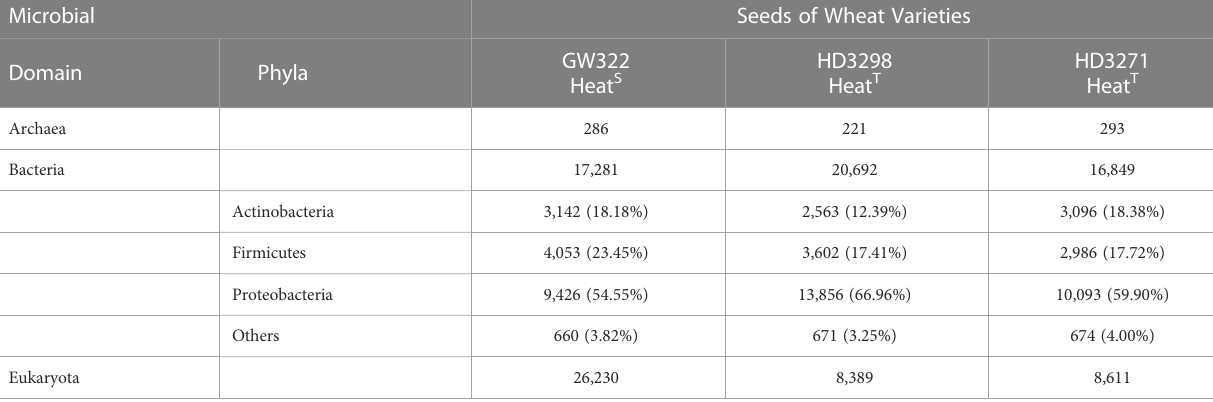
TABLE 3 Taxonomy abundance of microbial OTUs in the seed metagenome.